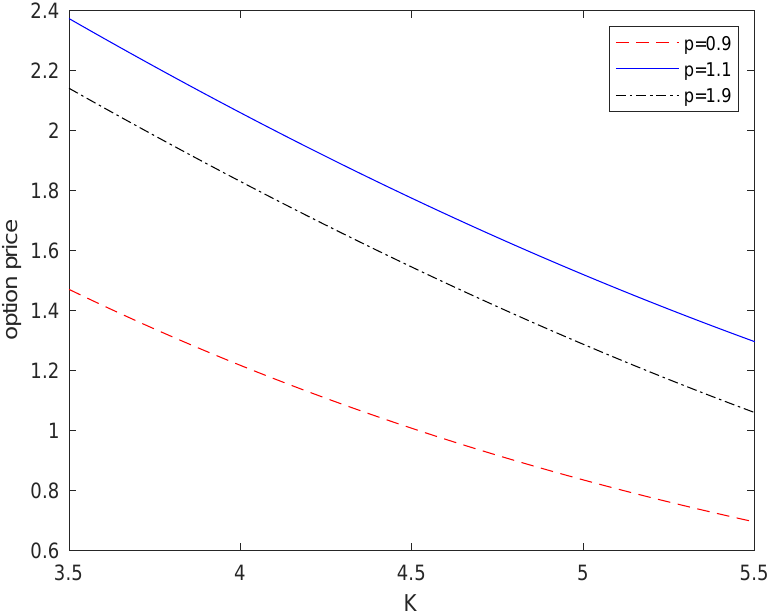
Figure 2. The price of the option with different K in [ 3.5,5.5 ] while p is constant.